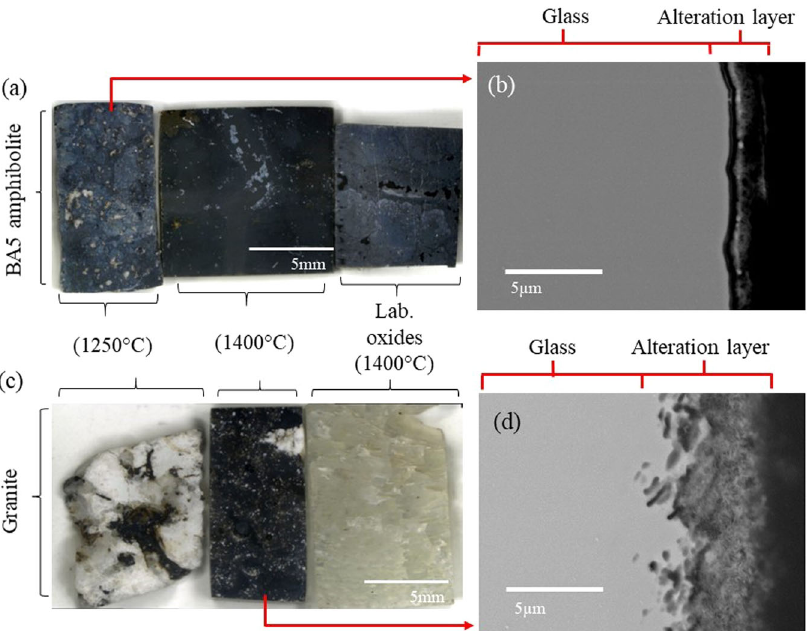
Fig. 4 Post-VHT images of various samples. a Coupons of BA5 amphibolite melted at 1250 °C and 1400 °C, and of laboratory oxides of similar compositions after VHT for 24 days at 200 °C and ( b ) corresponding BSE-SEM of a cross section of BA5 1250 °C. c Coupons of 443 Granite melted at 1250 °C and 1400 °C, and of laboratory oxides of similar compositions after VHT, for 24 days at 200 °C ( d ) and corresponding SEM of a cross section of 443 Granite 1400 °C.